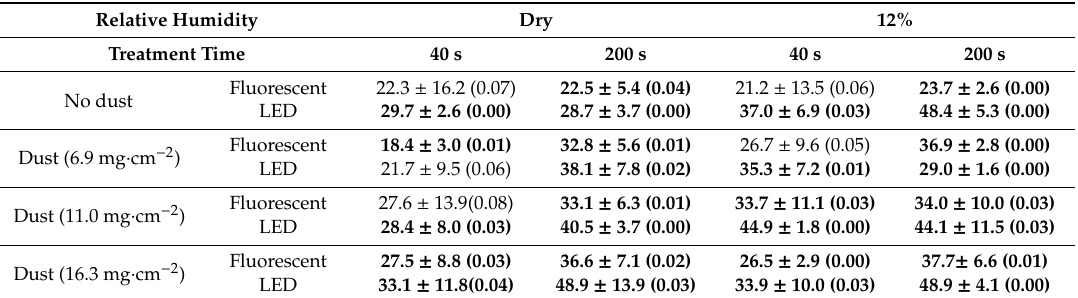
Table A15. O 3 mitigation under the di ff erent dust levels at a relative humidity of dry and 12% in photocatalysis. Value in the table report % reduction ± standard deviation ( p -value) and are an average between treatments of NH 3 and H 2 S standard gases. Bold font signifies statistical significance.